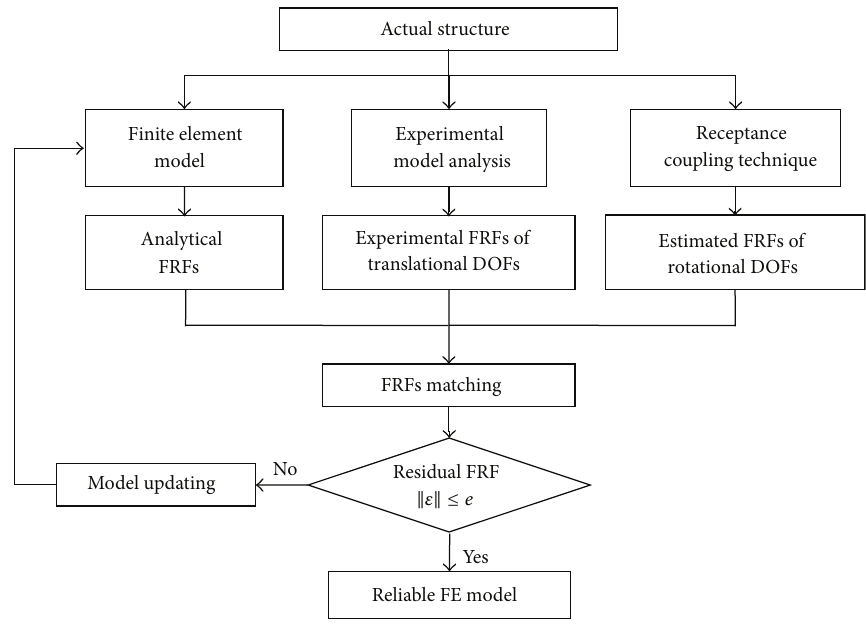
Figure 2: The flowchart of the proposed